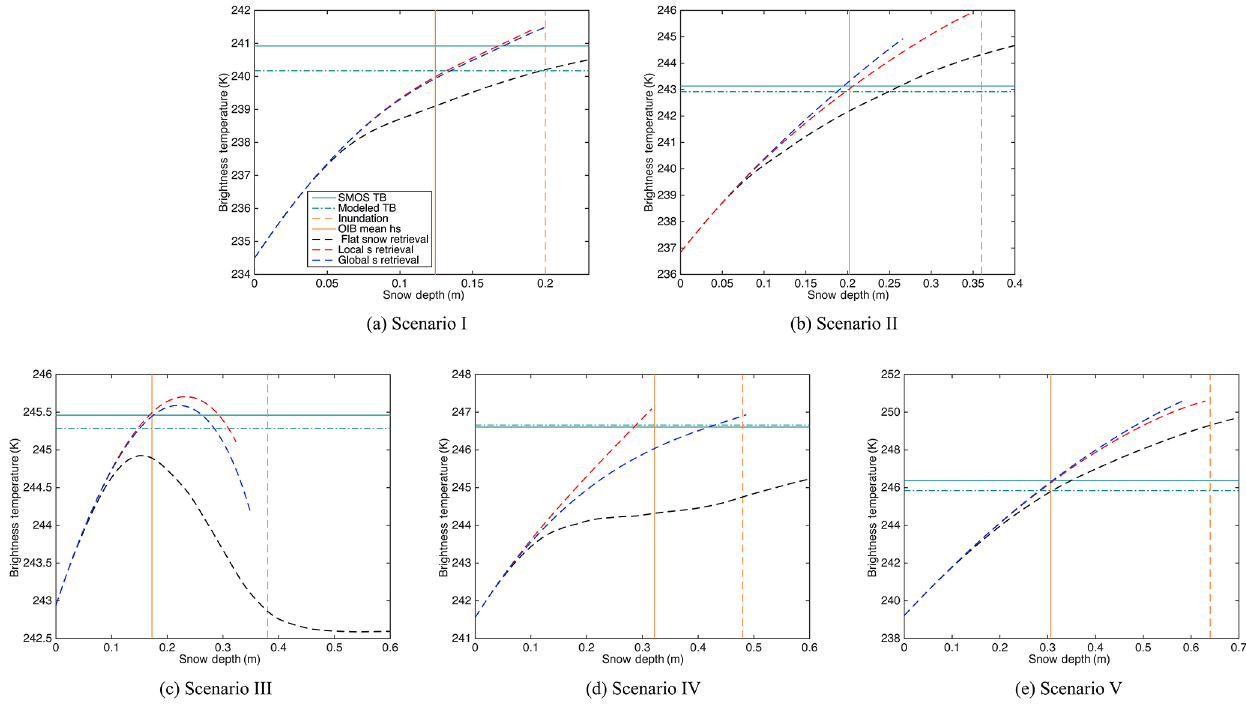
Figure 6. Retrievability study with different retrieval scenarios. The horizontal solid (dotted-dashed) lines are the SMOS (modeled) TB. The vertical solid lines represent the values of the mean snow depth from OIB observation. The black dashed curves denote the values of TB generated by scanning of h s under the flat snow cover assumption, and the vertical dashed lines denote the values of h s that result in 50% OIB samples to be inundated. The red (blue) dashed curves (with the corresponding mean snow depth) are the values of TB generated by scanning of α with the local (global) values of s as in Eq.